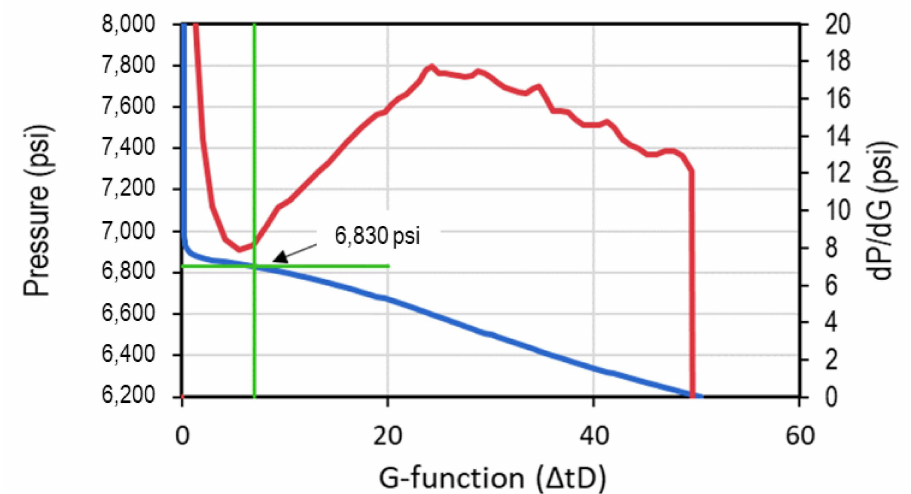
Figure 6. DFIT analysis using compliance method for Well #2 (Meramec Formation).